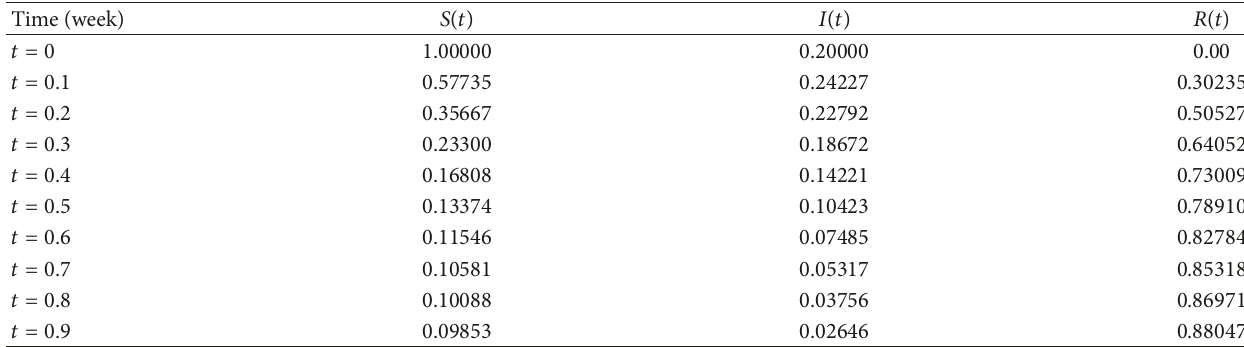
Table 2: Numerical solution of the proposed model using 𝑅𝐾4 at classical order 𝛼 = 1